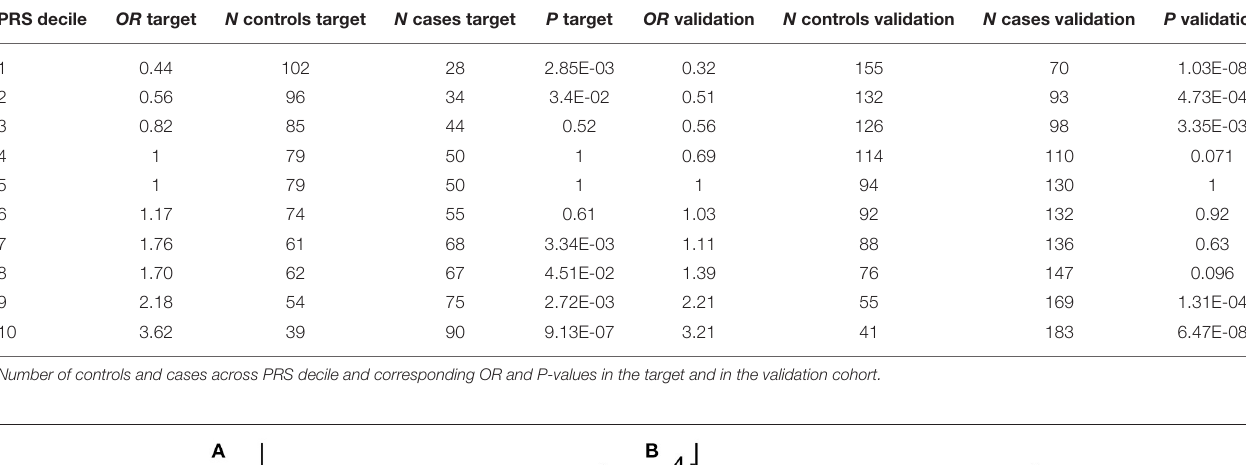
TABLE 2 | OR for hypertension across PRS deciles.